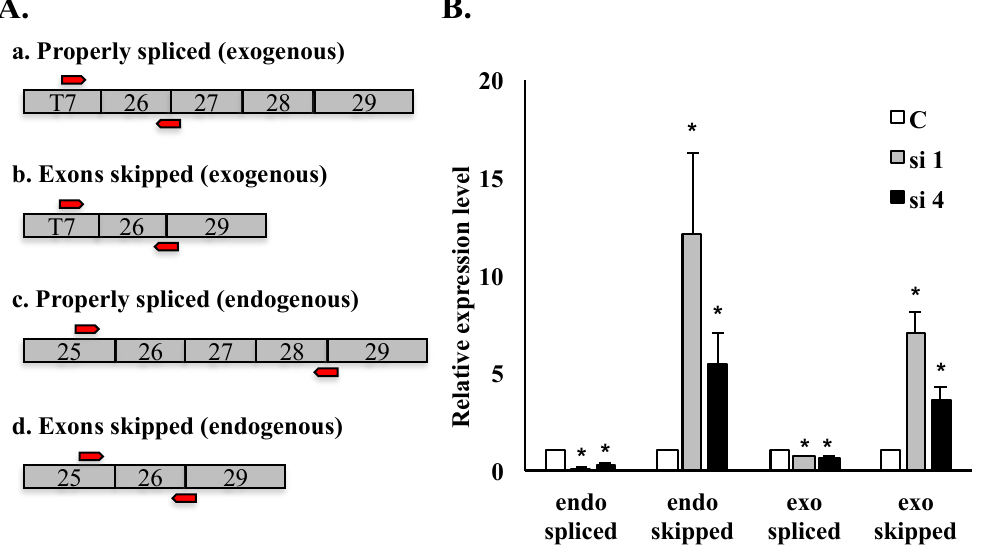
Figure 4. qRT-PCR analysis of HDAC6 exon skipping in SON-depleted cells. qRT-PCR performed on HeLa HDAC6 stable cells post-SON depletion. ( A ) Four sets of exon junction primers indicated by red arrows (see Experimental Section) were used to amplify splice variants of exogenous reporter transcripts as well as of endogenous HDAC6 transcripts; ( B ) Relative transcript level for properly spliced versus exon skipped transcripts is measured both for endogenous and for exogenous HDAC6 transcripts. Error bars were calculated by measuring standard error from three individual experiments ( * p ≤